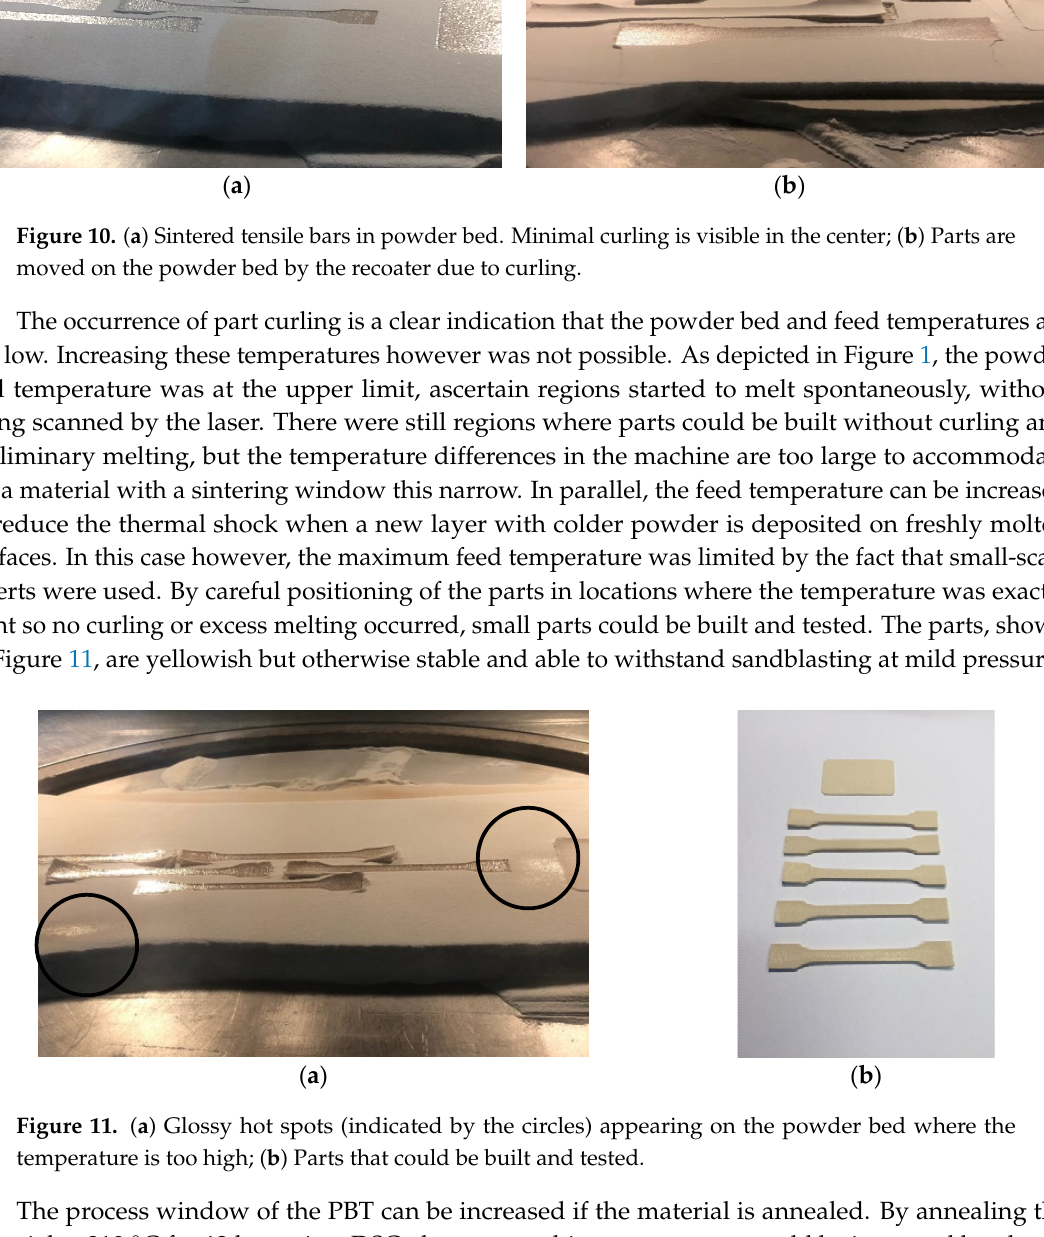
12 of 17 Figure 8. Differential scanning calorimetry (DSC) thermograms of PBT granulate (starting material) and produced PBT powder. 3.6. Rheological Properties The occurrence of degradation along the process chain from granulate to powder is confirmed by rheological measurements. In Figure 9, the apparent melt viscosity of two PBT grades is shown. The black curves correspond to the PBT 1200M, the red curves stem from the stabilized 1100-S600 PBT, which was transformed into a powder using the same methods as described above and shown in Figure 2. Both grades show considerable reduction of viscosity after having been processed into powder. From the DSC measurements, it appears from the shift in crystallization onset temperature, that degradation already begins during the first process step of melt blending. Further steps including washing and drying however also contribute to degradation. Considering the high surface-to-volume ratio of the small particles and the large amounts of water used, hydrolysis is a substantial problem that must be addressed in future work. Figure 9. Apparent viscosity of PBT granulates and powders at 250 °C. 3.7. Laser Sintering Multiple laser sintering trials were carried out to test the performance of the powder in a commercial laser sintering machine and to find the optimal process parameters. The powder flowability was excellent. The powder could be deposited at process temperature without any issues.